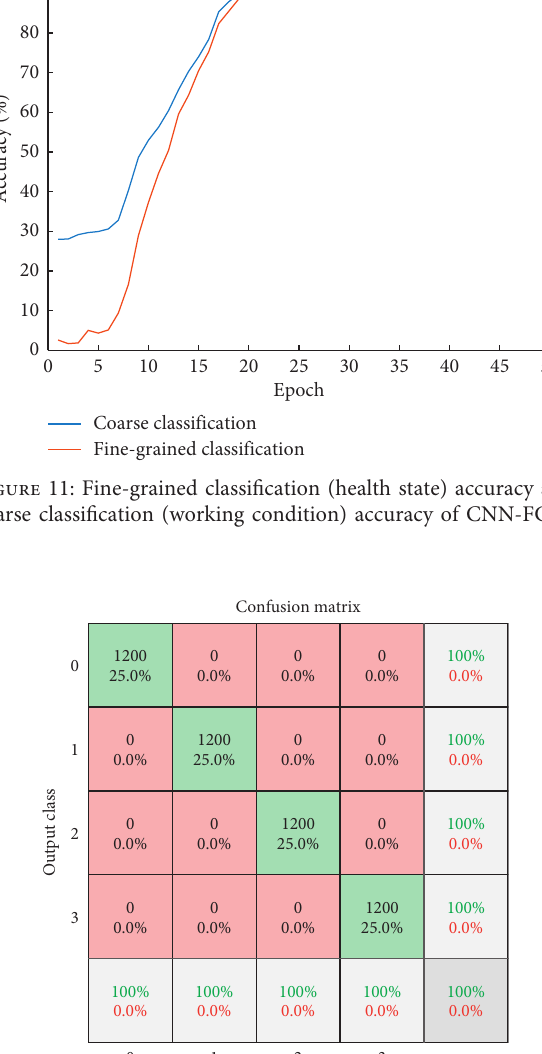
Figure 10: The t-SNE visualization figure of features extracted from CNN-M.